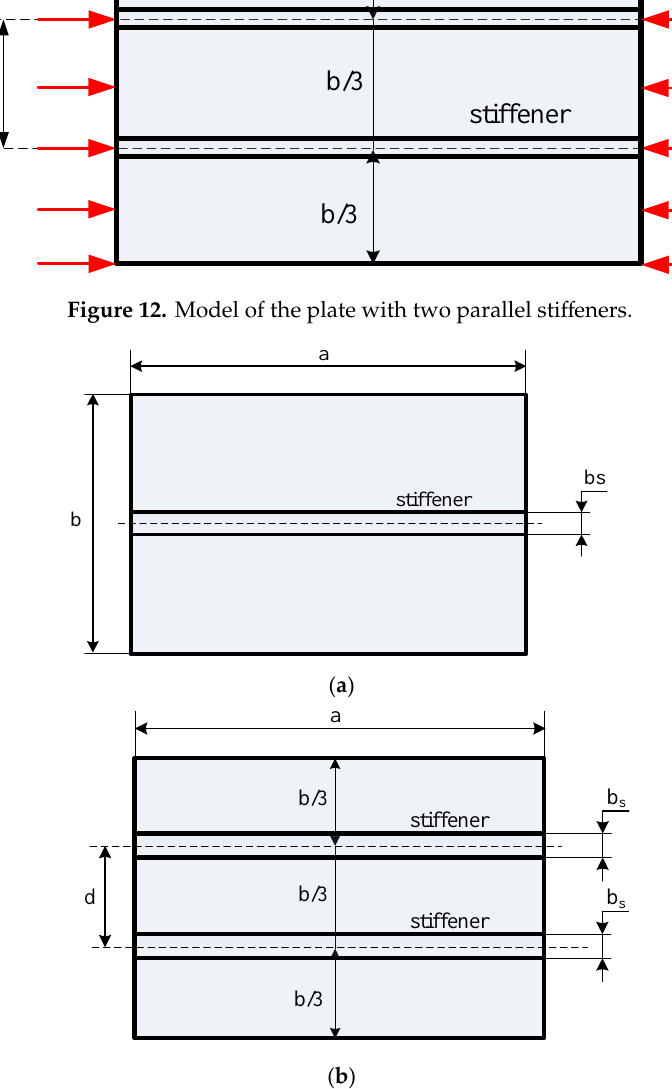
Figure 13. Plate with one stiffener and two stiffeners. ( a ) Plate with one stiffener; ( b ) plate with two